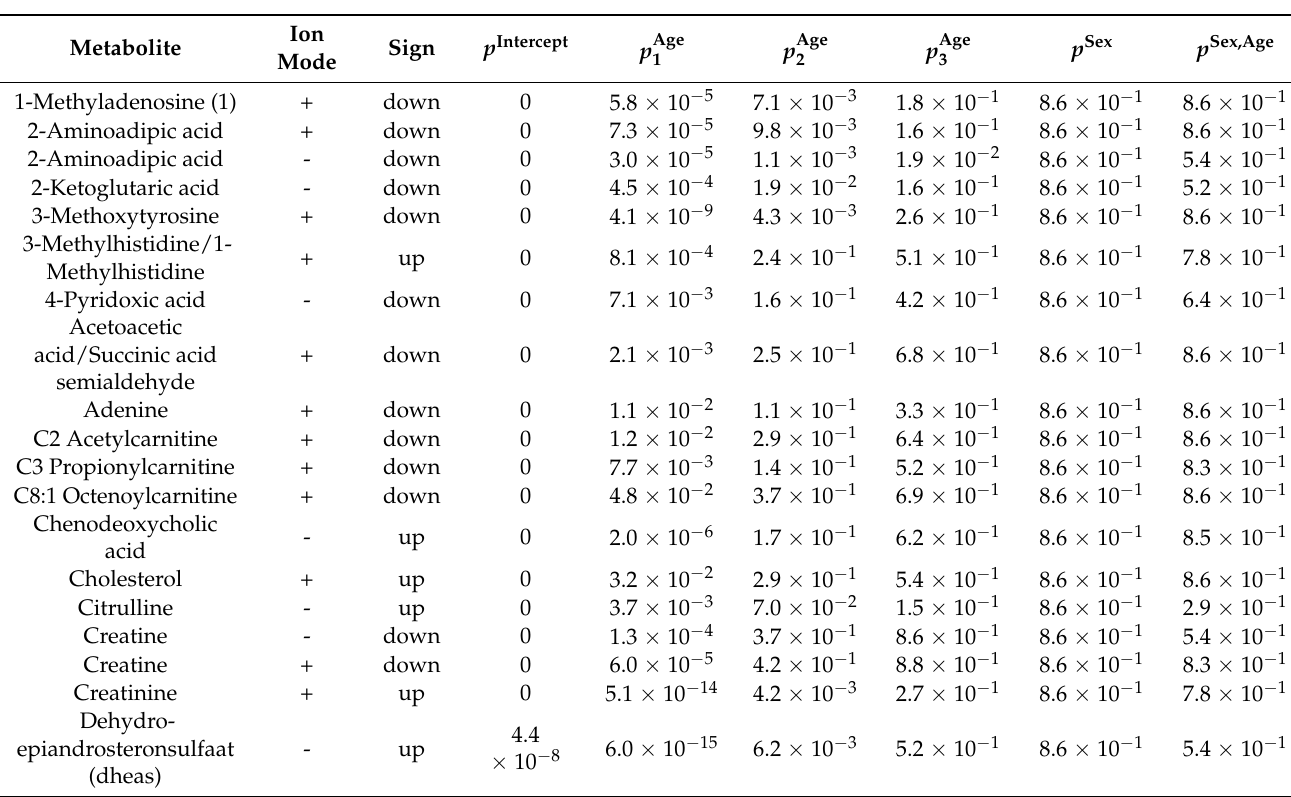
Table A3. Significant age related metabolites (corrected p -value p Age